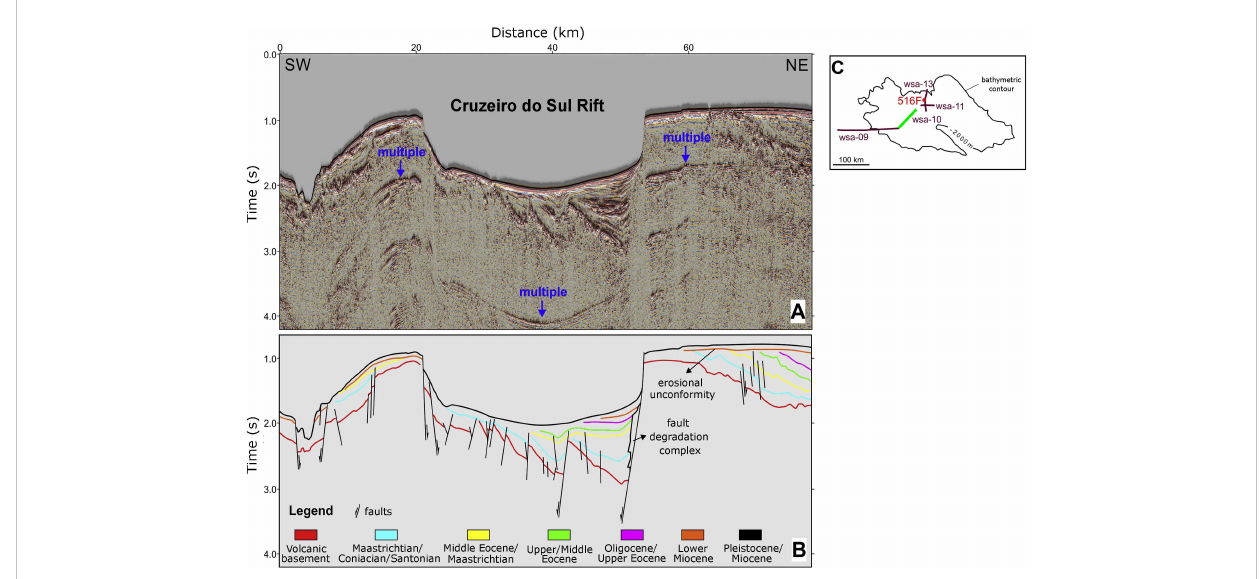
FIGURE 4 Raw (A) and interpreted (B) seismic pro fi le wsa-10, located in the northern Cruzeiro do Sul Rift as shown in (C) by the green line (adapted from Praxedes et al.,